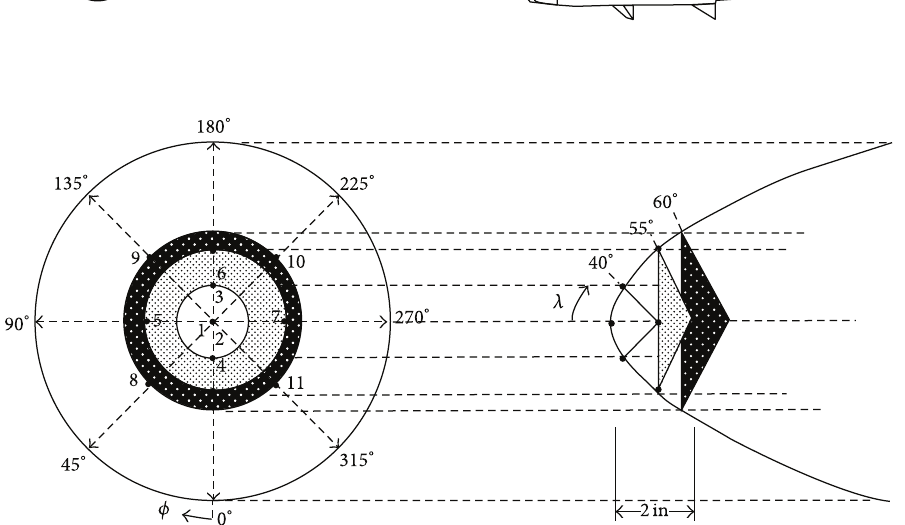
icing effects and are less prone to damage during operation and maintenance. They are an ideal choice for stealth vessels because they are self-sustained and give no additional radar cross-sectional area to the vessel